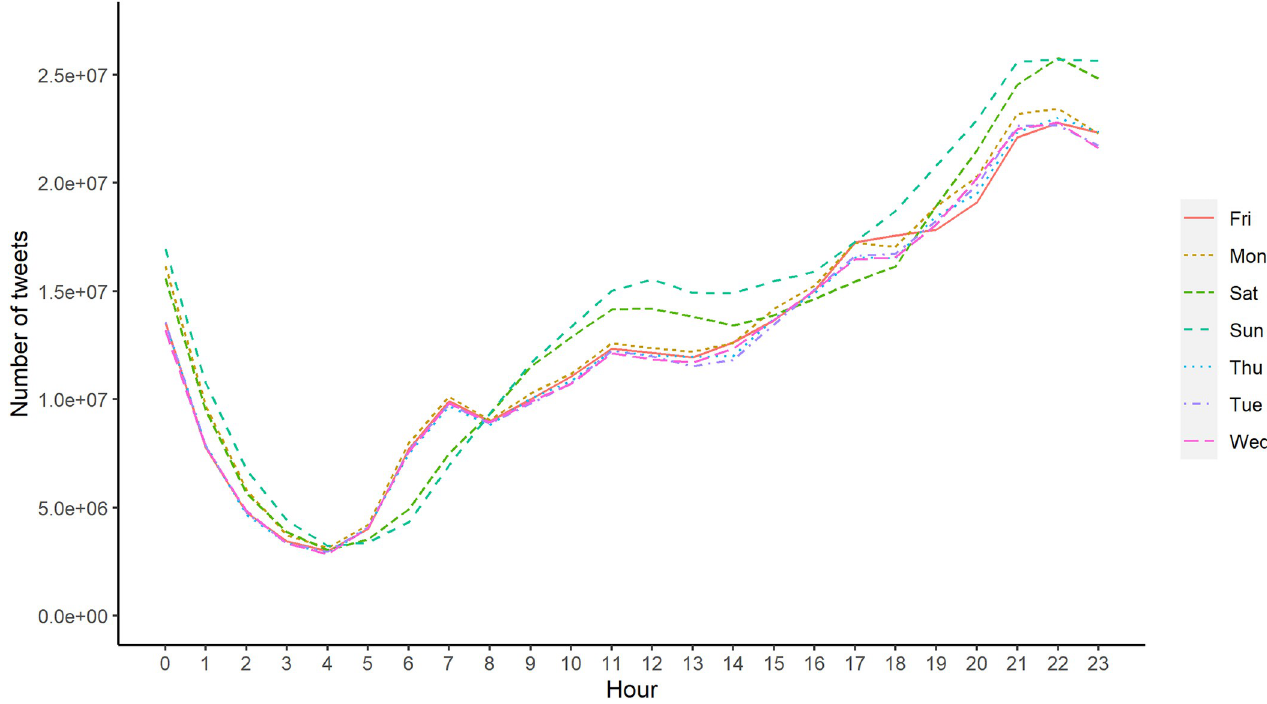
Fig 8. Number of tweets posted by hour of the day and day of the week.